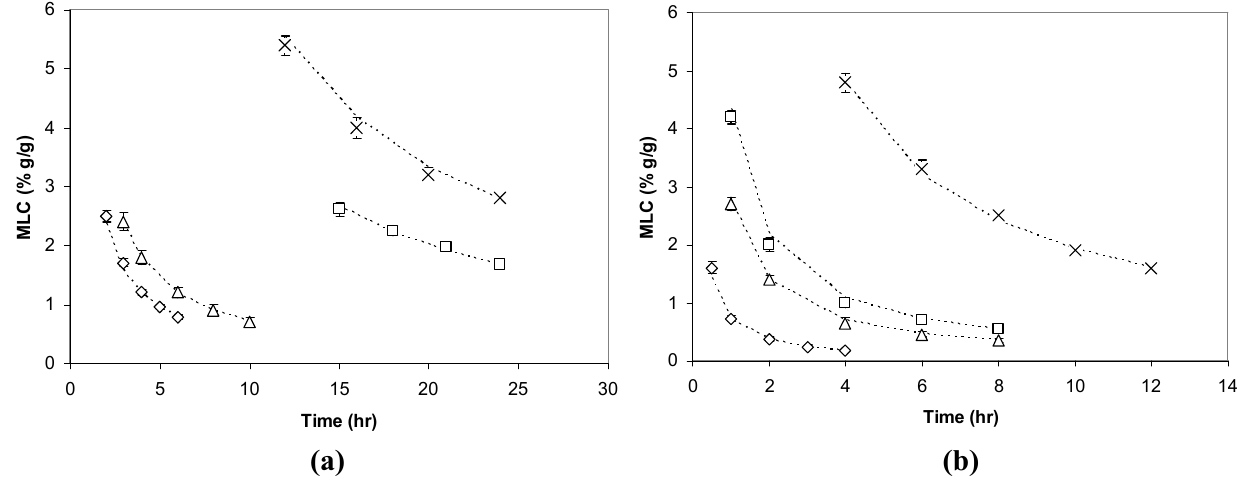
Figure 2. Minimal lethal concentration (MLC) of dialdehyde starch aqueous suspension against E. coli (a) and S. aureus (b) versus exposure time at four different temperatures, experimental data, × 4 ° C, □ 14 ° C, ∆ 23 ° C, ◊ 34 ° C, and the fitted dot lines calculated from the equations in Table 2.